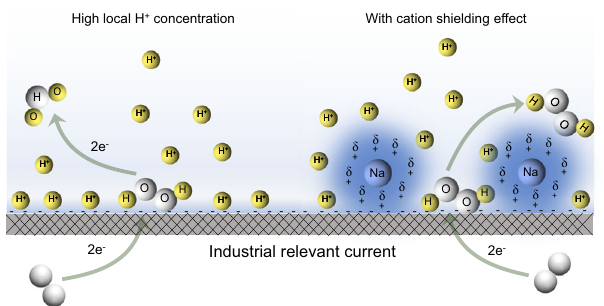
Fig. 1 Schematic illustration of 2e − – ORR toward H 2 O 2 in acid with/ without Na + under industrial-relevant current. Here we report a cation- regulated catalyst/electrolyte interface to promote electrochemical O 2 reduction to H 2 O 2 in acids with high-selectivity and industrial-relevant production rates. By adding only a small amount of alkali metal ions into the acidic electrolyte, which barely affects the solution ’ s pH, we demonstrated a dramatic improvement in H 2 O 2 selectivity and activity especially under large ORR current densities across different catalysts. Our molecular dynamic simulations suggest that the solvated alkali metal cations, compared to concentrated protons in acids, could preferentially be attracted to the catalyst/electrolyte interface and squeeze out local protons during the reaction, suppressing the further reduction of as-generated H 2 O 2 to H 2 O (Fig. 1). Using commercial carbon black catalysts with 10 mM Na 2 SO 4 as an additive, the H 2 O 2 Faradaic ef fi ciency (FE) can reach over representing a 25-fold improvement compared to the case without Na + additive where negligible H 2 O 2 was produced (<5% FE). Based on this cation promotion concept, a double-PEM-based solid electrolyte (SE) reactor was developed for a continuous generation of H 2 O 2 with high FE ( ∼ 90%) and good stability (over 500 h) for practical applications in the